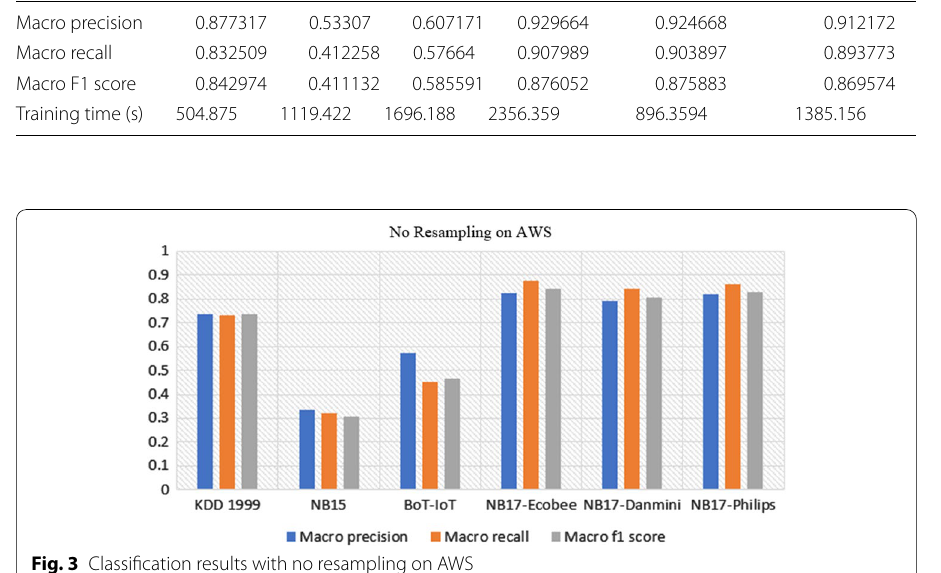
Fig. 3 Classification results with no resampling on